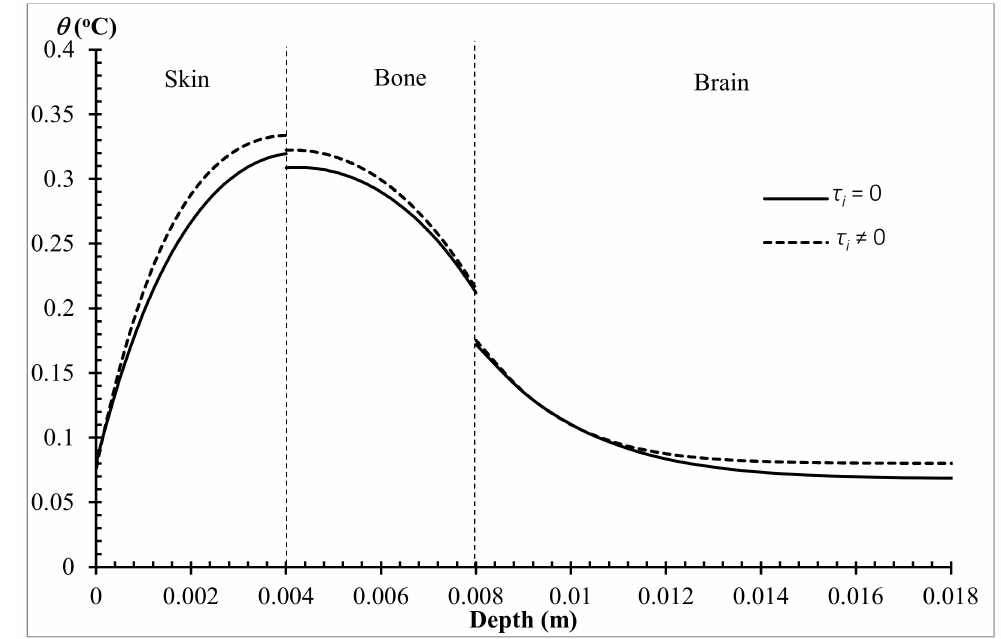
Figure 16. The dynamical temperature increment with various relaxation times on an adult’s head.